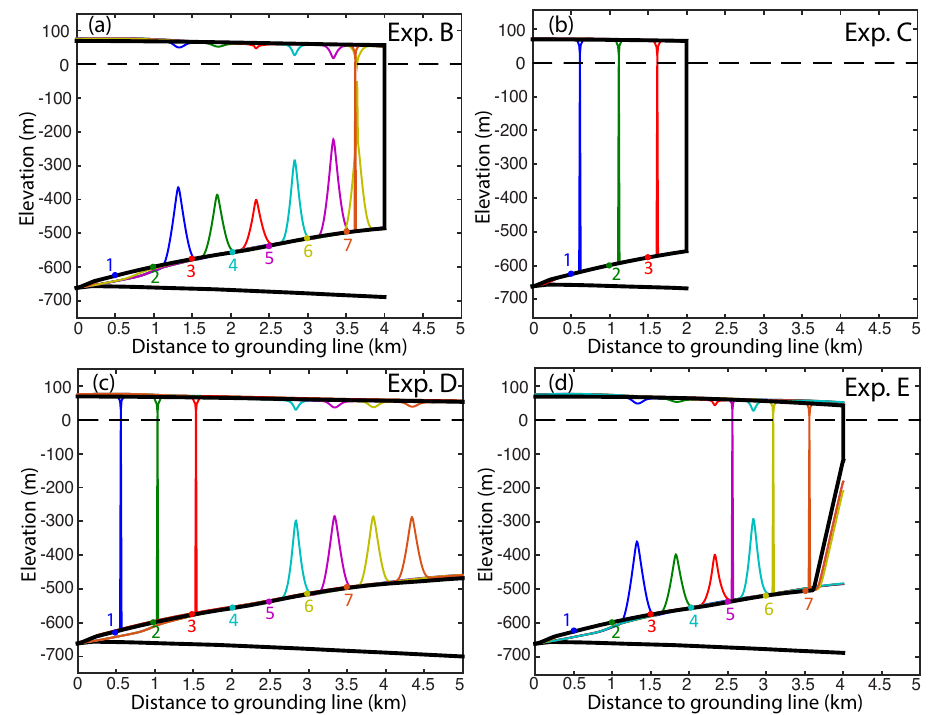
Figure 10. Crevasse propagation in the grounding line region with varying initial geometry. In each panel, solid lines are the shape of final crevasses with (a) 4km long ice shelf (Exp. B1–B7), (b) 2km long ice shelf (Exp. C1–C3), (c) 3m deep, 100m wide initial surface crevasse (Exp. D1–D7), and (d) 4km long ice shelf with a 400m wide and 400m high undercut ice front (Exp. E1–E7). The black lines are the initial geometry for ice surface, ice bottom and